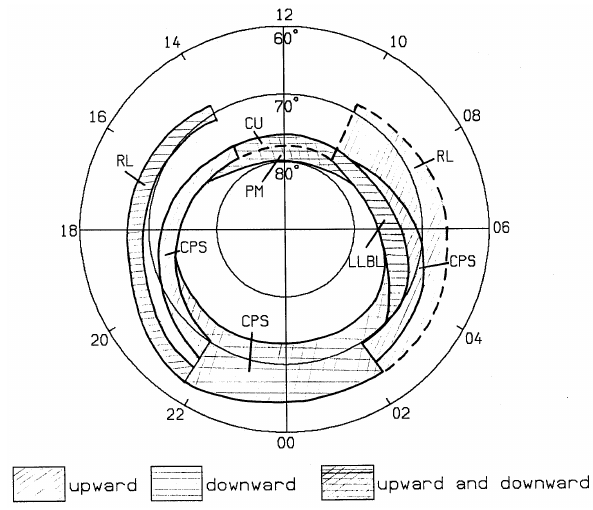
Fig. 17. Spatial distribution of downward/upward FACs in geomag- netic latitude–local geomagnetic time coordinates. Plasma domains in the magnetosphere connected by magnetic field lines with the corresponding ionospheric FAC regions are